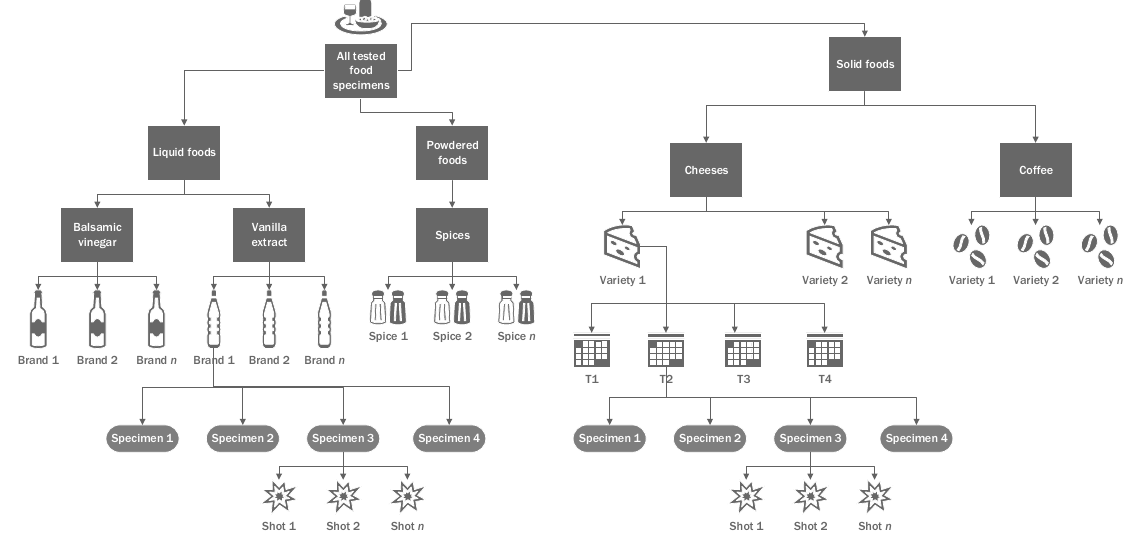
Figure 2. Diagram illustrating the variety of food examples and the testing procedures employed in the presented experiments. Each food product was represented by multiple specimens, each of which was interrogated repeatedly by LIBS. Please note that only cheeses were sampled at multiple time intervals.